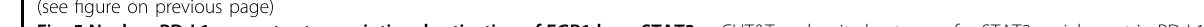
Fig. 5 Nuclear PD-L1 promotes transcriptional activation of EGR1 by p-STAT3. a CUT&Tag density heatmap of p-STAT3 enrichment in PD-L1- silenced cells and control cells within 3 kb around TSS. b IGV tracks for EGR1 from p-STAT3 CUT&Tag analysis of PD-L1-silenced cells and control cells. c , d ChIP – qPCR assay of the p-STAT3 status at the EGR1 promoter and its upstream and downstream regions after PD-L1 silencing in MUM2B ( c ) and MEL290 ( d ) cells. e – g RT-PCR detection of relative STAT3 ( e ), EGR1 ( f ) and VEGFA ( g ) mRNA expression in MUM2B and MEL290 cells after STAT3 knockdown. n = 3. Data are presented as means ± SD. Two-tailed unpaired Student ’ s t -test. h Western blot images showing the protein levels of p-STAT3, STAT3, EGR1 and VEGFA in STAT3-silenced cells and control cells. i – k Gene expression correlation analysis of STAT3 and PD-L1 ( i ), STAT3 and EGR1 ( j ), STAT3 and VEGFA ( k ) in UM patients using TCGA database. l Kaplan-Meier analysis of the overall survival of UM patients with low and high STAT3 expression levels using TCGA database. m Schematic diagram showing that nPD-L1 and p-STAT3 coactivated EGR1 transcription in